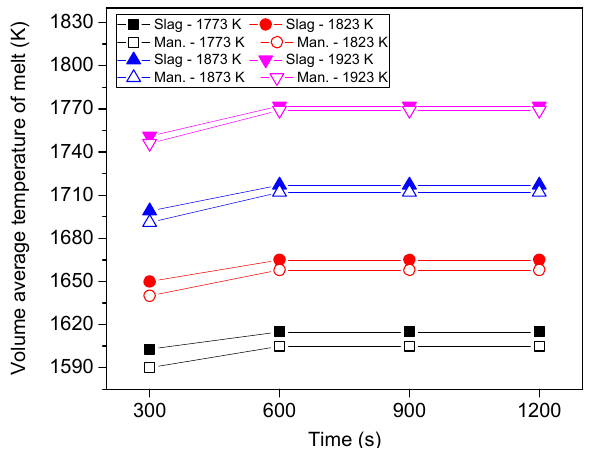
Figure 12. Effect of heating temperature on calculated volume average temperature of melt. Figure 12. E ff ect of heating temperature on calculated volume average temperature of melt. Metals 2019 , 9 , 751